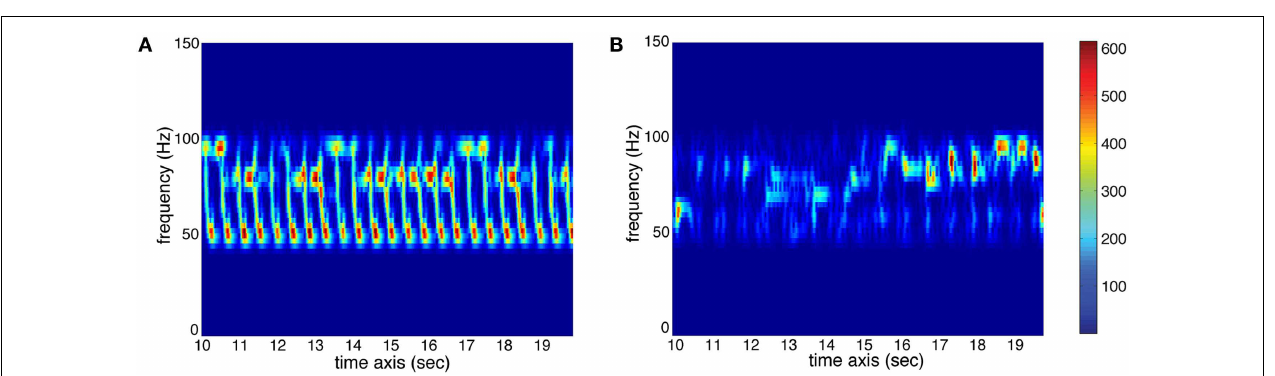
FIGURE 3 | Spectrograms (sec. 10–20) of sub-band no. 2 (50–100Hz) of two stimuli used in the study. (A) High amount of temporal change (red represents high energy at the respective time and frequency, whereas blue